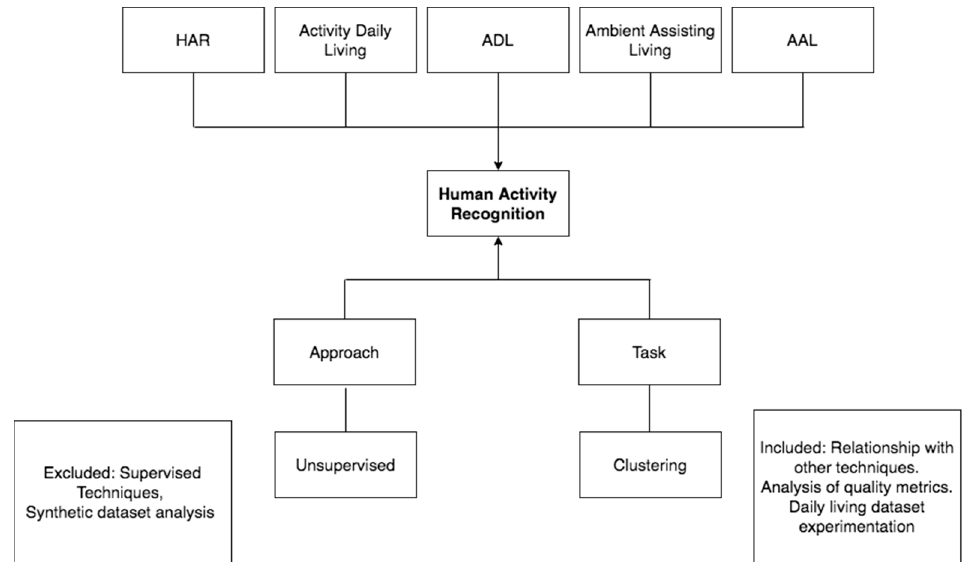
Figure 8. Search features of review. HAR—Human Activity Recognition; ADL—Activities of Daily Living; AAL—Ambient Assisting Living.